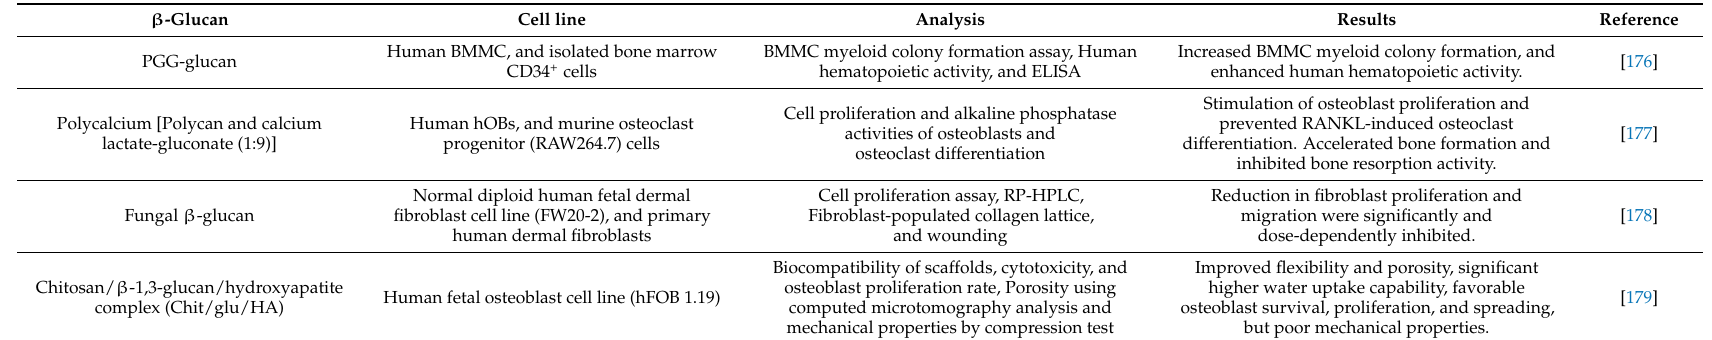
Table 8. Bone regeneration/bone injury healing effects of β -glucans—in vitro study.